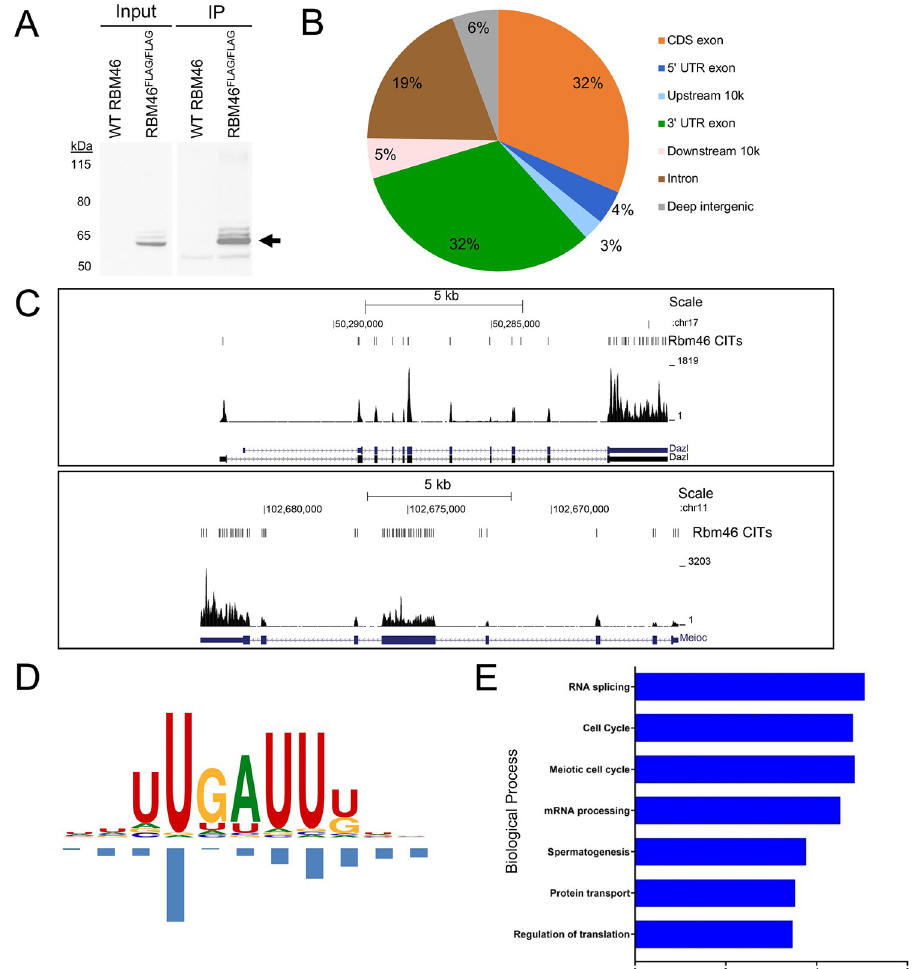
Fig 6. RBM46 sequence-specific binding to a specific cohort of mRNAs encoding factors required for RNA processing and meiosis. ( A ) FLAG-stained western blot of lysates from Rbm46 WT/WT and Rbm46 FLAG/FLAG showing input and immunoprecipitated proteins, respectively. Band at the expected protein size is indicated by arrow. ( B ) Genomic distribution of RBM46 binding in the testis, displayed as percentages of binding to each sequence feature. ( C ) Representative UCSC genome browser view showing exonic binding of RBM46 across Dazl and Meioc . ( D ) WebLogo showing U-rich RNA binding sequence motif identified using mCross as the most enriched sequence at the RBM46 crosslink sites. ( E ) Gene ontology analysis performed using EnrichR showing the top biological processes of RBM46-bound mRNAs.